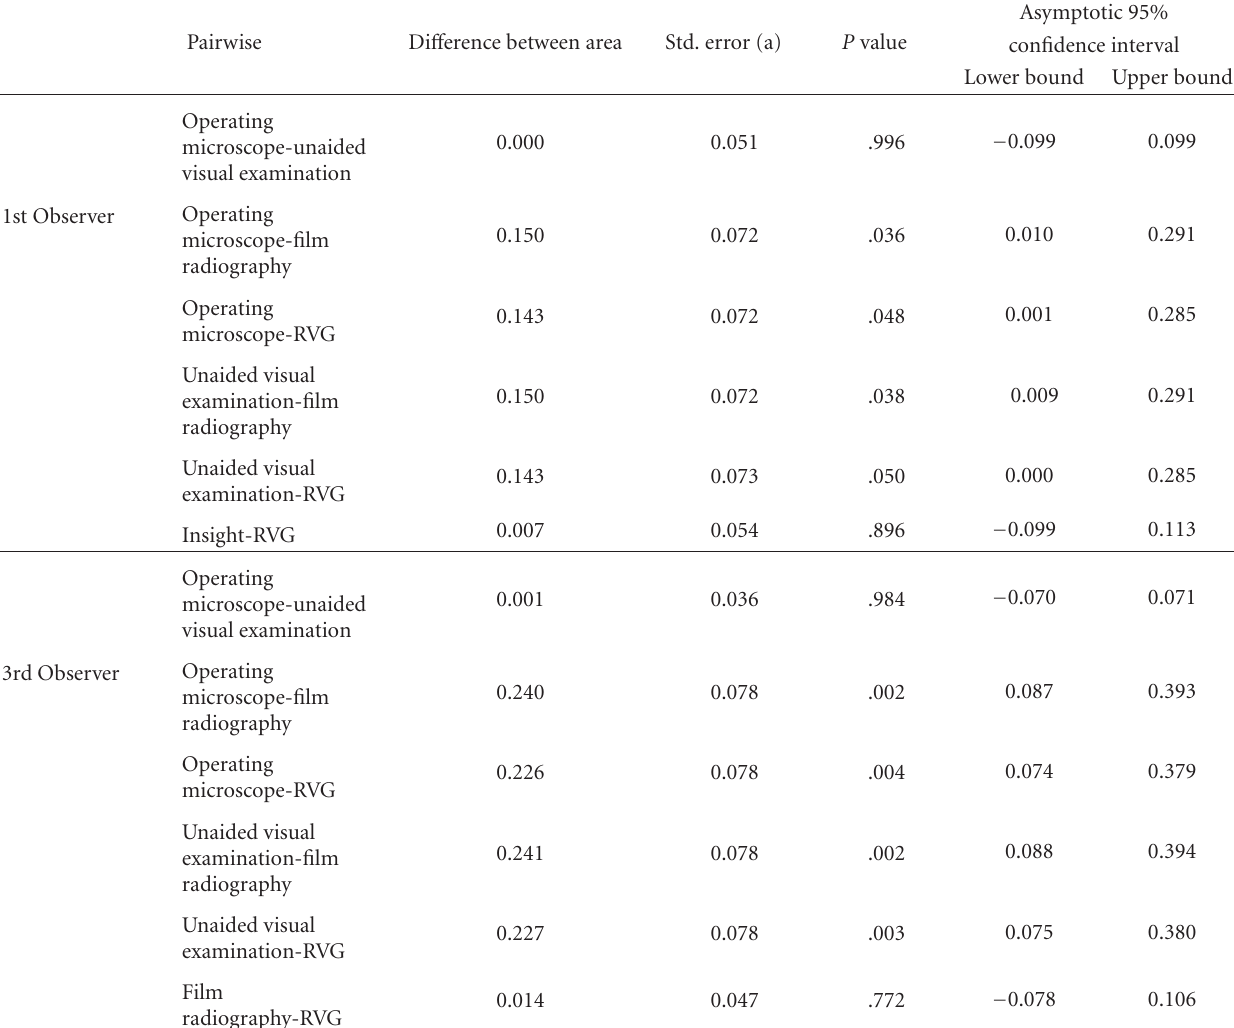
Table 5: Pairwise comparisons of A z